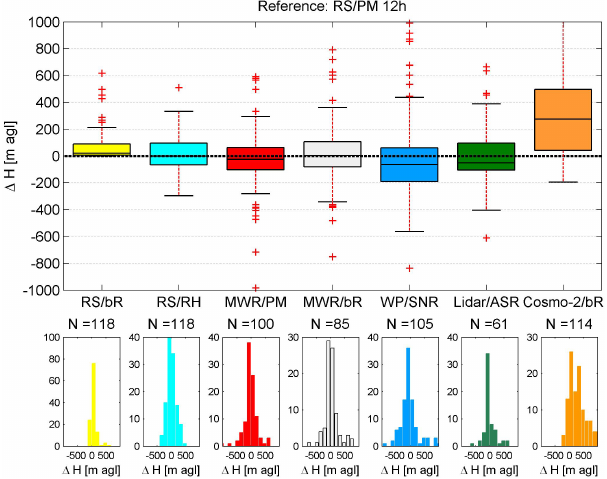
Figure 6. Boxplots of PBL height differences (cid:49)H between RS/PM and other methods/instrumentation computed at 12:00. The central box line is the median, the edges of the box are the 25th and 75th percentiles ( q 1 and q 3 ) , the whiskers enclose all data points not con- sidered outliers, and the red crosses are the outliers. Data are con- sidered as outliers if they are larger than q 3 + 1.5 · (q 3 – q 1 ) or smaller than q 1 –1.5 · (q 3 – q 1 ) , which means that whiskers cover 99% of data assuming a normal distribution. The (cid:49)H statistical distribution and the number of data points N for each boxplot are given in the sub- plotted histograms, data points greater than 1000m being displayed in the last column of the corresponding